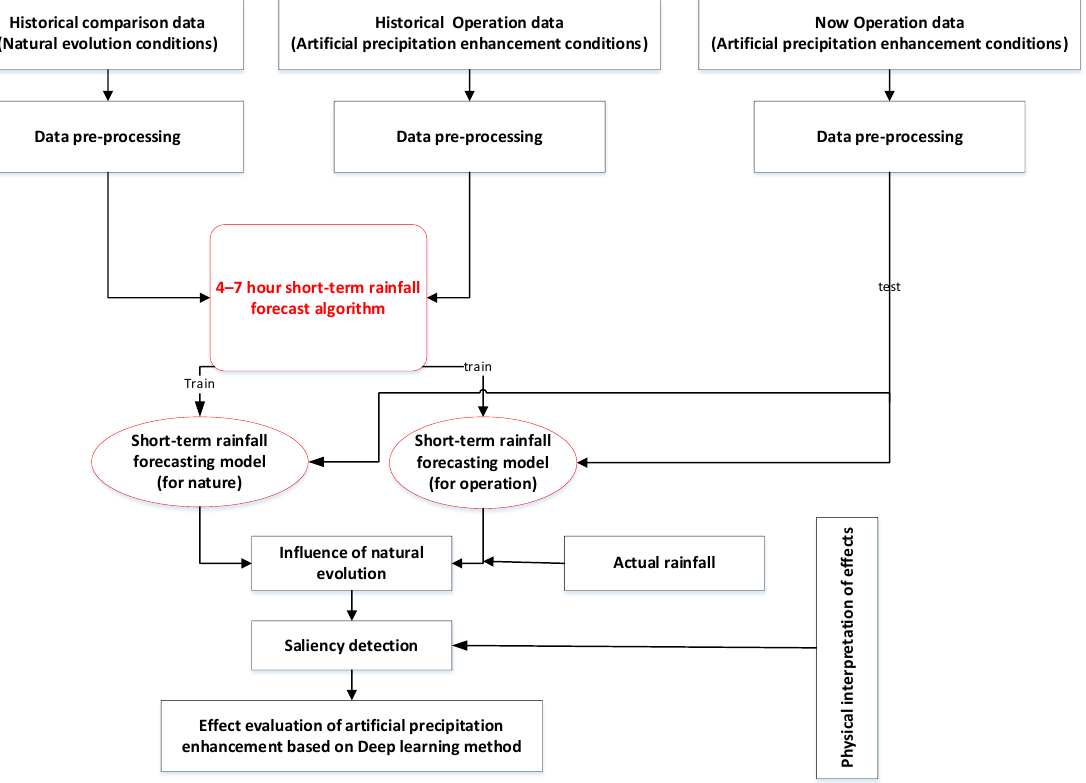
Figure 3. Evaluation scheme of artificial precipitation enhancement based on deep learning.